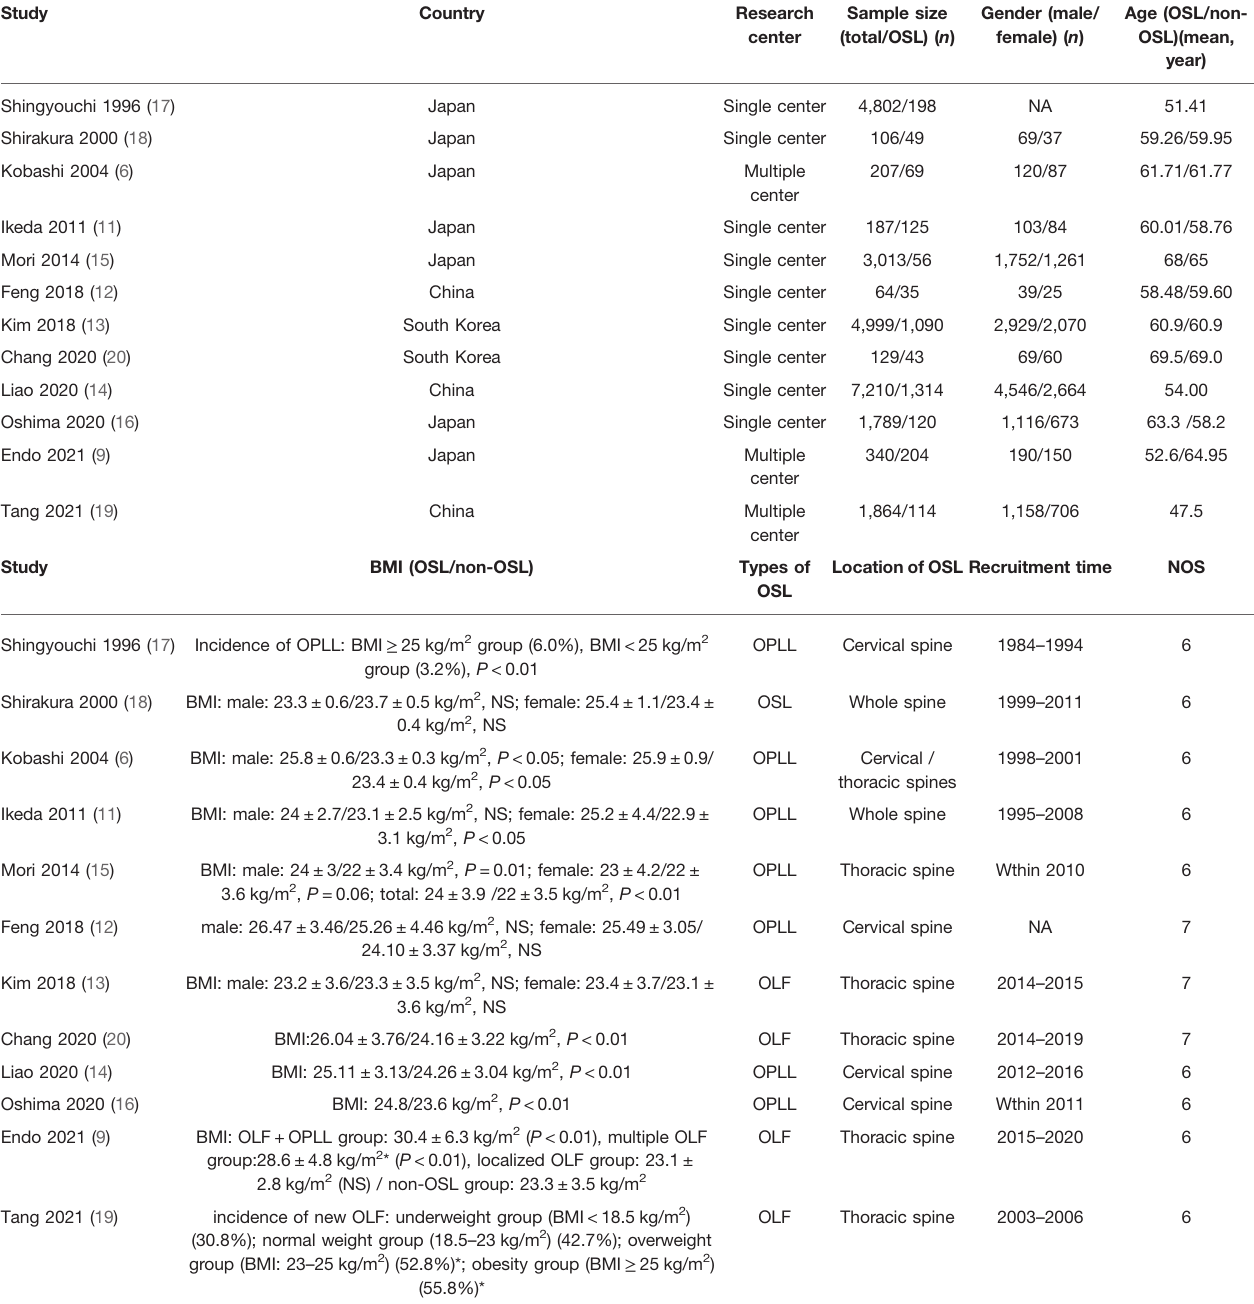
OSL, ossi fi cation of spinal ligaments; BMI, body mass index; NOS, Newcastle – Ottawa scale; OPLL, ossi fi cation of the posterior longitudinal ligament; OLF, ossi fi cation of the ligamentum fl avum; NS, not signi fi cant (P>0.05); NA, not available.